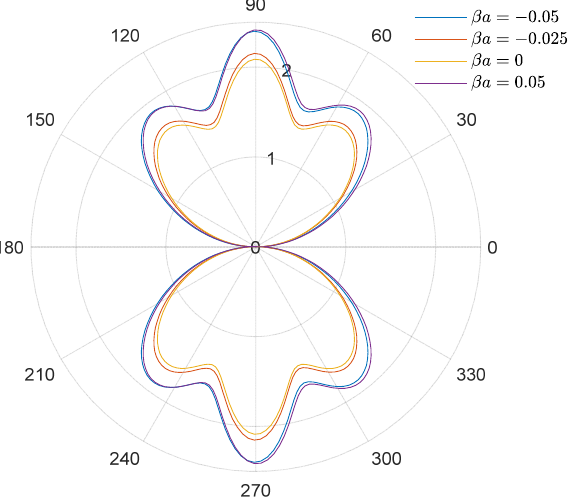
Figure 2. Polar graph of DSCC around the elliptical opening with ka = 0.1 and m = 1/6. Taking ka = 0.1 and β a = − 0.05, 0, 0.025, 0.05, the stress amplitudes around